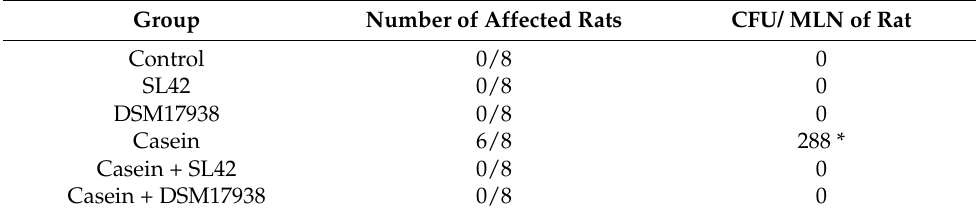
Table 4. Bacterial translocation to mesenteric lymph nodes in rats subjected to casein challenge.